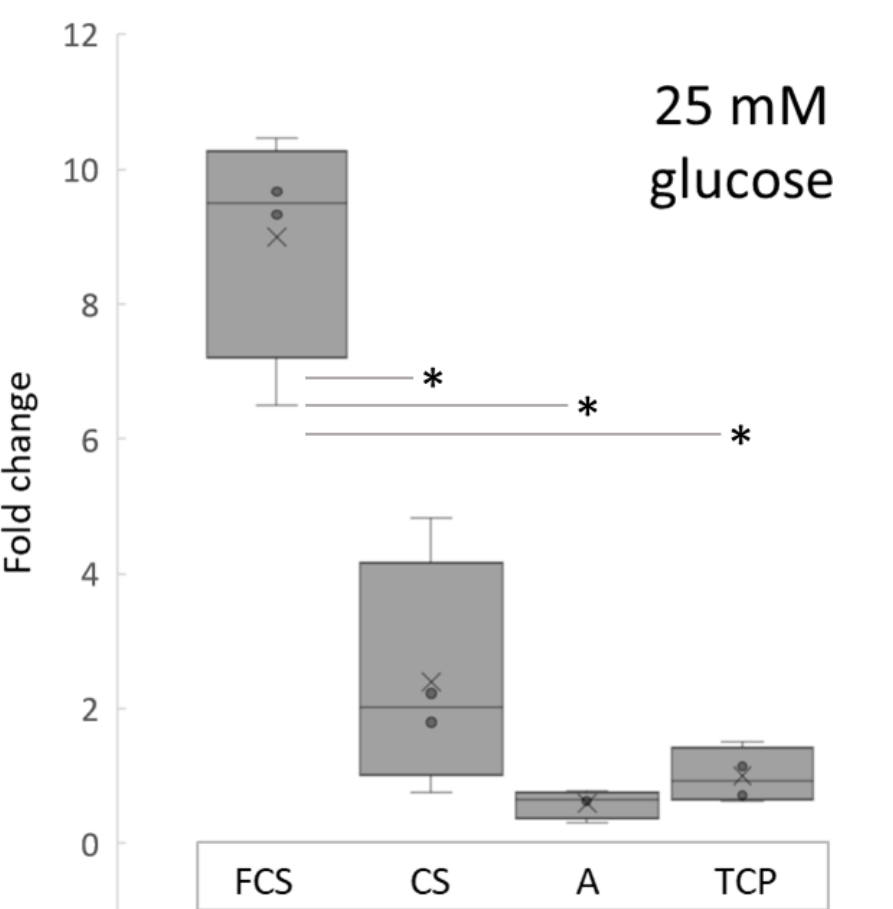
Figure 4. Normalized induced insulin secretion relative to TCP in supernatants of MIN-6 cells cultured on different scaffolds, after 25 mM glucose challenge. Insulin values were normalized to the cell counts in each group. * p ≤ 0.005.